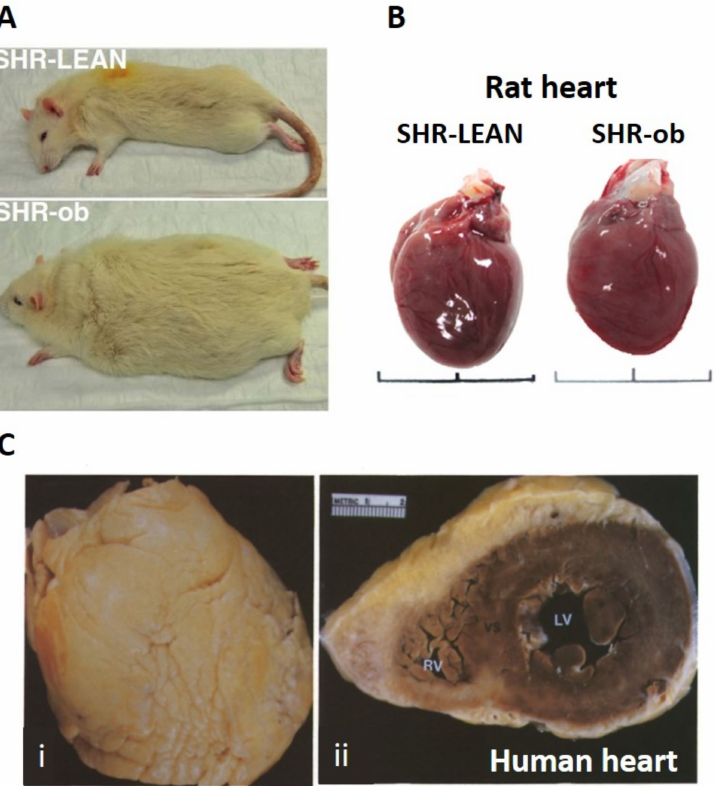
Figure 2. EAT thickness between lean and obese rats in panels ( A , B ) compared to EAT thickness found on the heart of an 83-year-old overweight female in panel ( C ). Reproduced from Krishnan et al. [17] under the Creative Commons Attribution